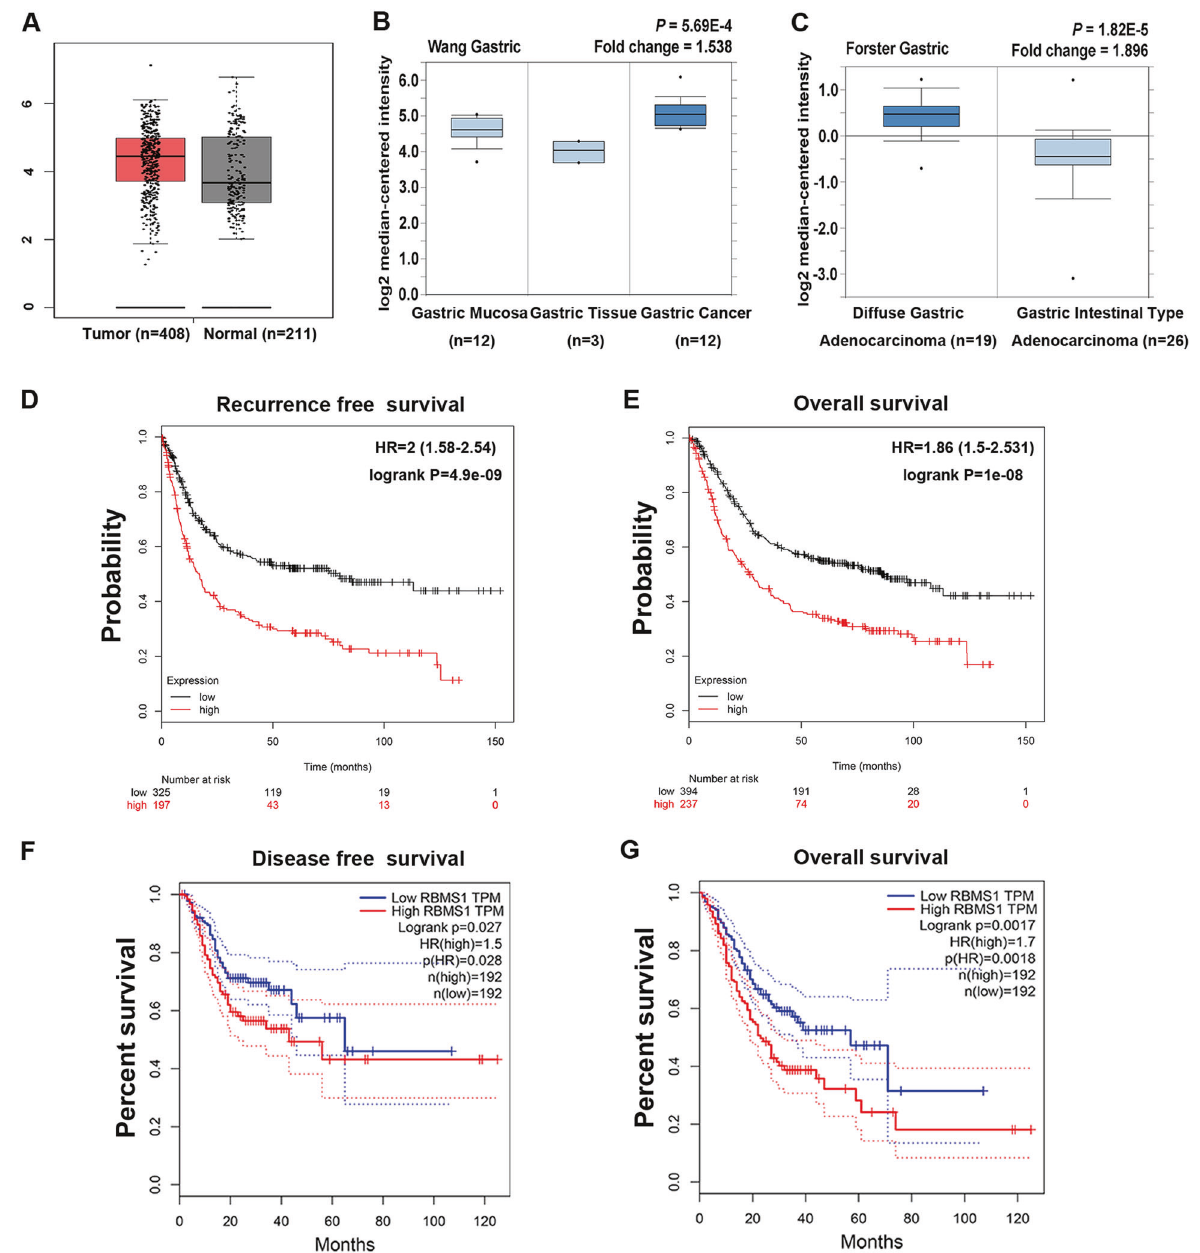
Fig. 2 RBMS1 overexpression predicts a poor prognosis in GC patients based on the TCGA and Oncomine databases. A Analysis of RBMS1 expression using the Gene Expression Pro fi ling Interactive Analysis (GEPIA) website (http://gepia.cancer-pku.cn/). B , C Analysis of RBMS1 expression based on the Oncomine database. Analysis of the associations between RBMS1 and recurrence-free survival ( D ) or overall survival ( E ) in GC patients performed via the Kaplan – Meier plotter database. Analysis of the associations between RBMS1 and the disease-free survival ( F ) or overall survival ( G ) of GC patients based on the TCGA